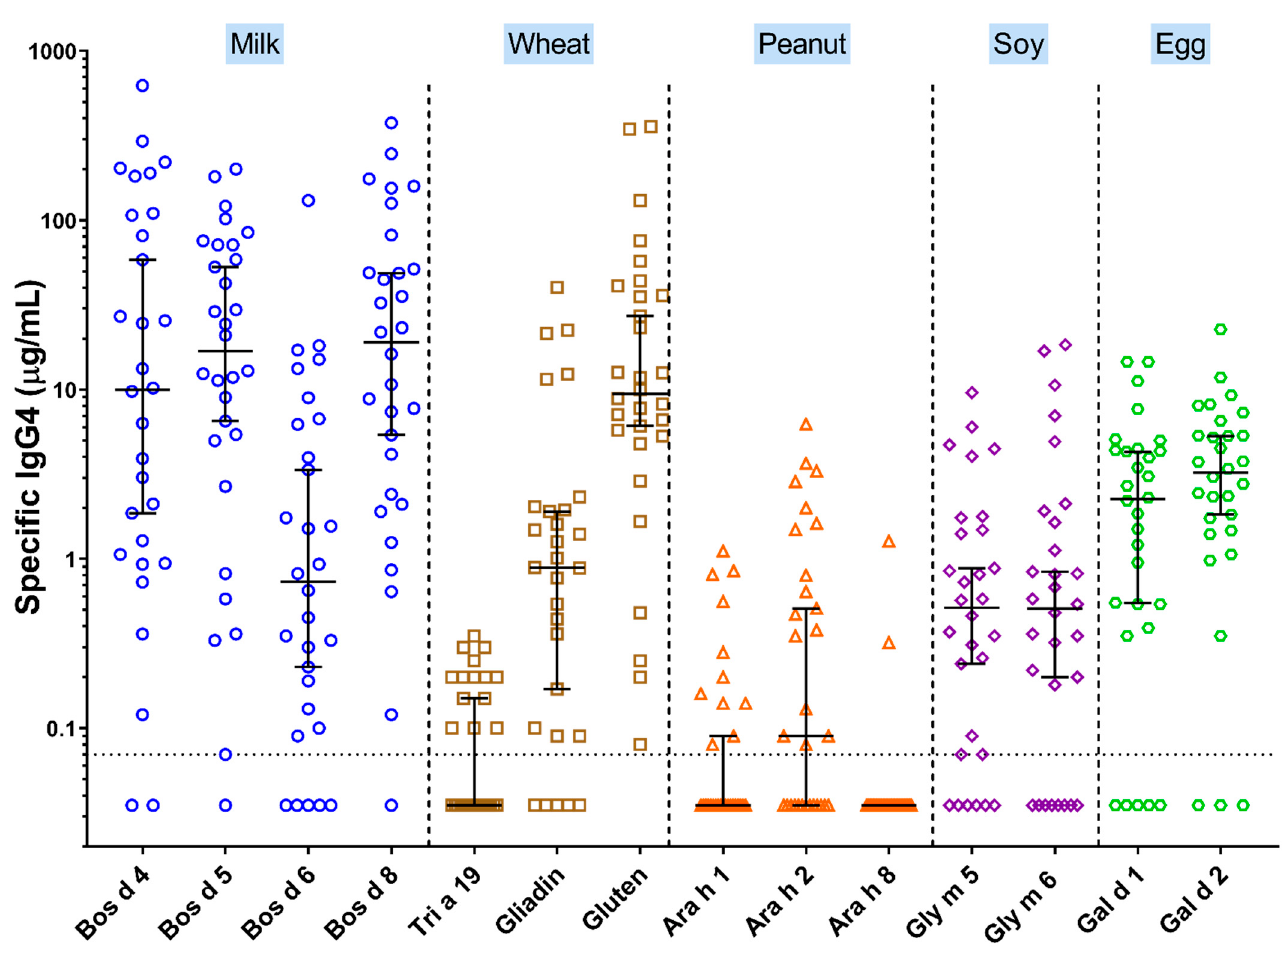
Figure 3. IgG4 to multiple allergens in serum from 30 children with EoE (Adapted from Schuyler et al. [15]).